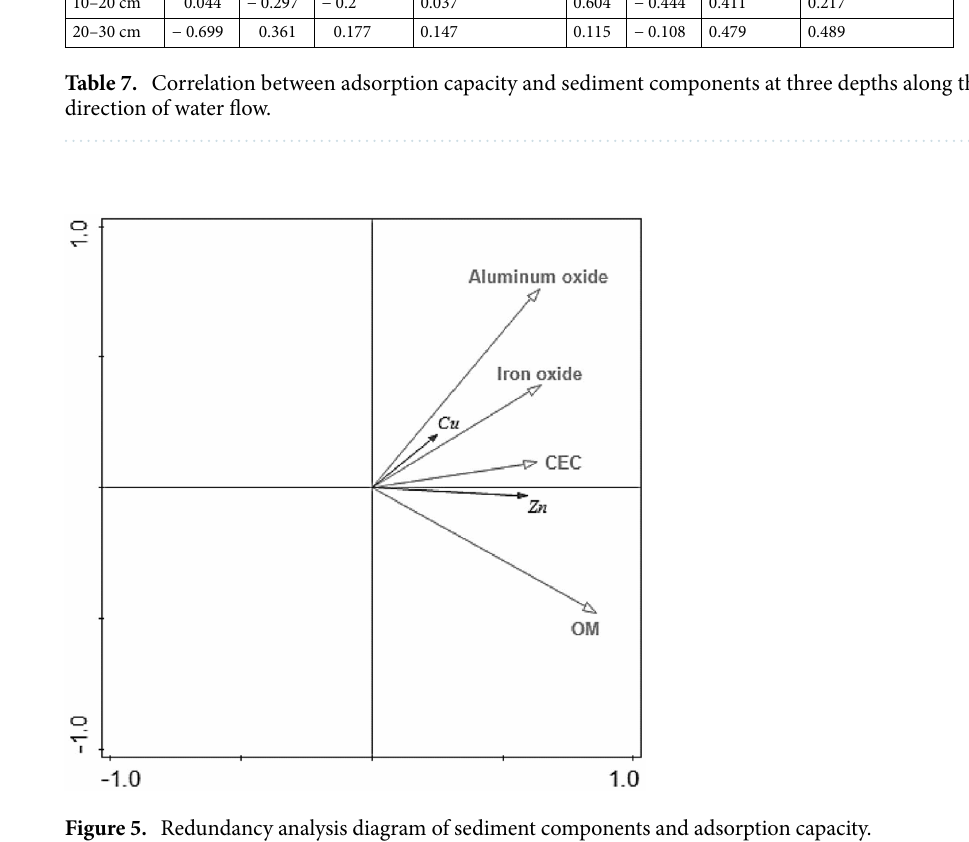
Figure 5. Redundancy analysis diagram of sediment components and adsorption capacity.